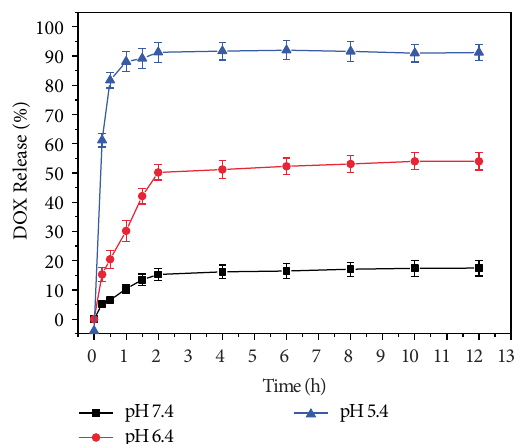
Figure 4: Time-dependent DOX release from the multiple layer coating MCNs in PBS with the different pH